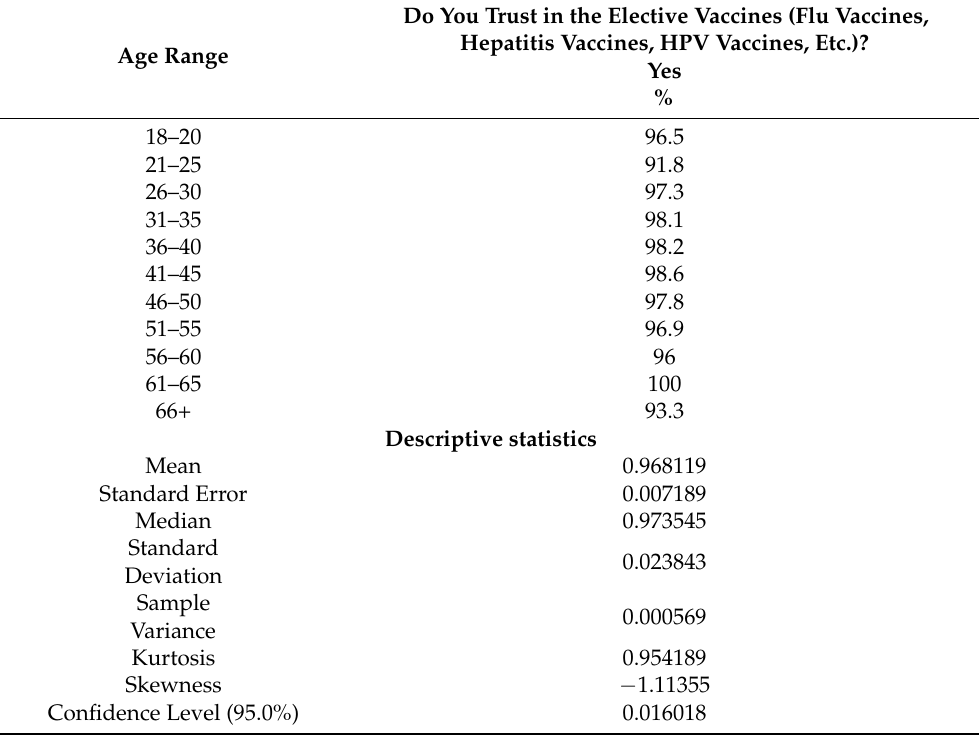
Table 4. Participants’ trust in the optional/elective vaccines.